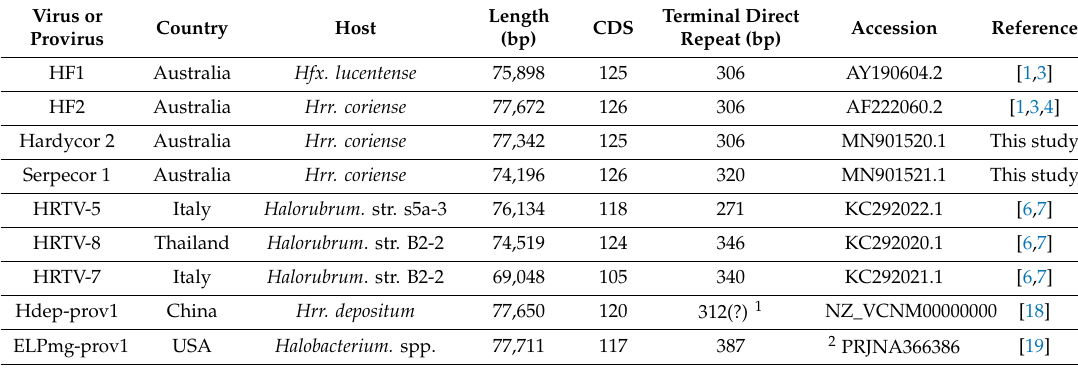
Table 2. Characteristics of HF1-like viruses.